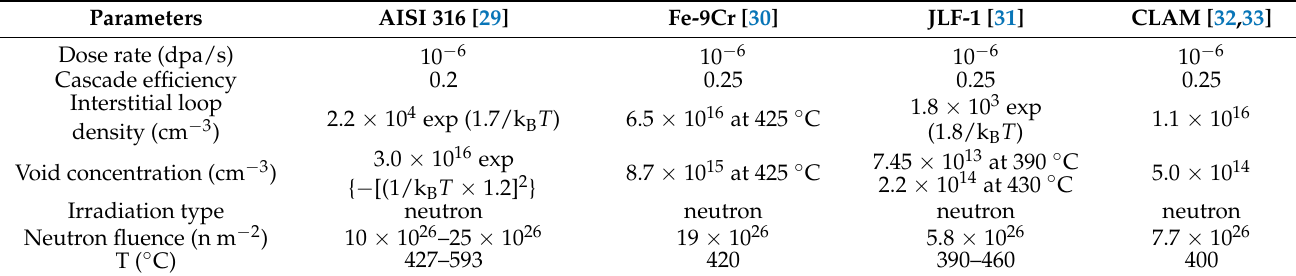
Table 3. Neutron irradiation parameters of AISI 316, Fe-9Cr, JLF-1, and